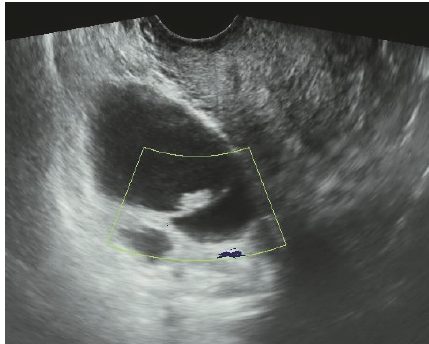
Figure 1: Ultrasonography demonstrated two cystic lesions in the right ovary. Color Doppler ultrasonography did not show neovascu- larity in the right ovary.